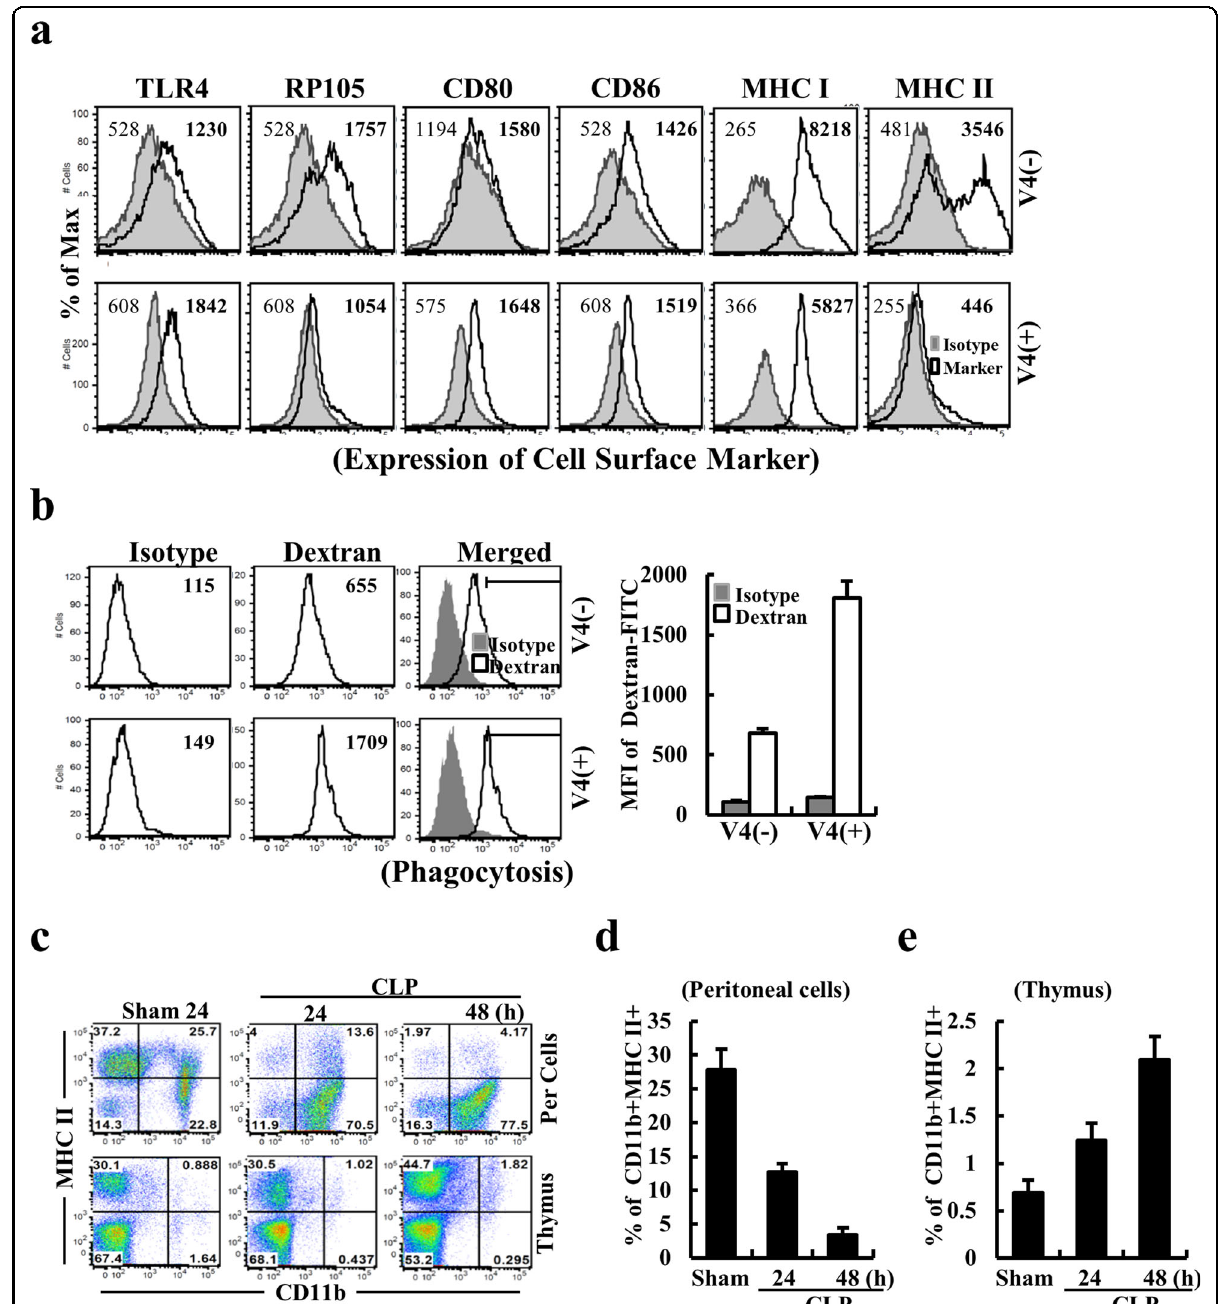
Fig. 4 Analysis of the phenotype, phagocytosis, and migration of V4( + ) cells. a Peritoneal cells were isolated from wild-type mice, and V4( + ) and V4( − ) cells were puri fi ed using anti-VSIG4 antibody and MACS MicroBeads. Cells were stained with TLR4, RP105, CD80, CD86, MHC I, and MHC II antibodies, and analyzed by fl ow cytometry. The data represent the average value of triplicates. b V4( + ) and V4( − ) cells were cultured with dextran for 30 min, and phagocytic cells were analyzed by fl ow cytometry. The data represent the average value of triplicates. c Puri fi ed V4( + ) cells were injected into peritoneal cavity of sham or CLP mice. Peritoneal cells and thymocytes were isolated from sham or CLP mice for 24 and 48 h. Cells were stained with CD11b and MHC II antibodies, and analyzed by fl ow cytometry. d Number of CD11b( + )/MHC II( + ) cells from peritoneal cavity and e thymus as shown in ( c ) were counted. The data represent the average value of